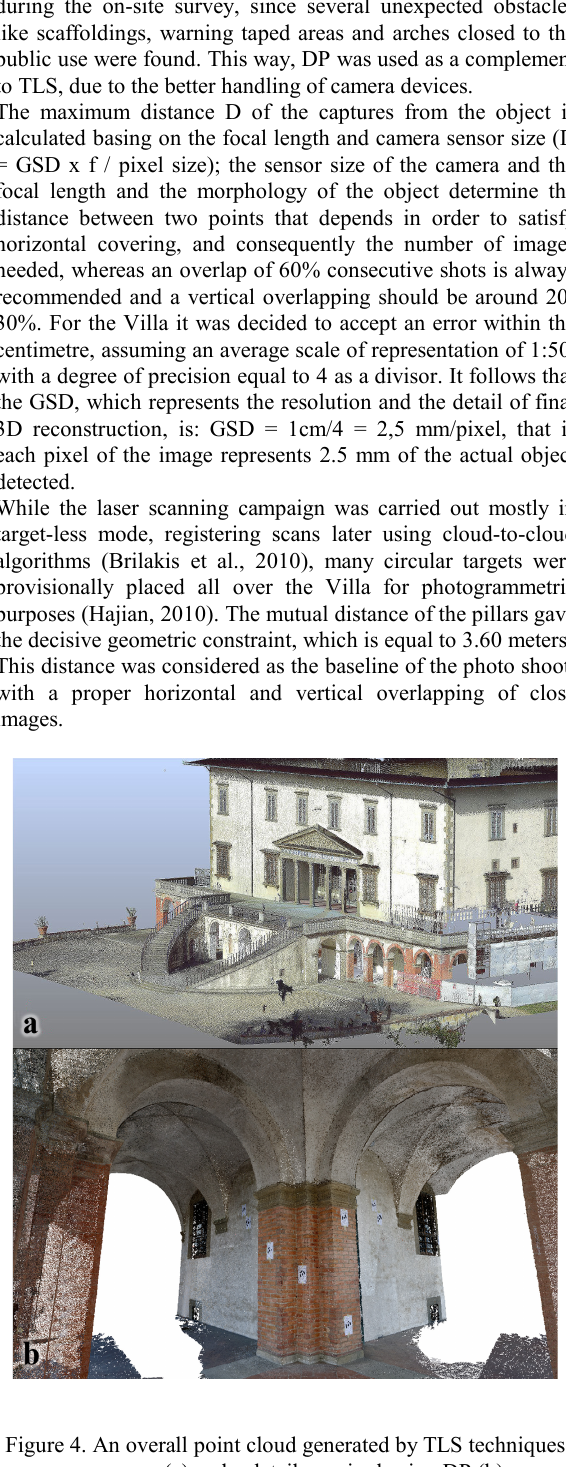
Figure 4. An overall point cloud generated by TLS techniques (a) and a detail acquired using DP (b). The image files have been kept at maximum resolution and minimum compression with automatic